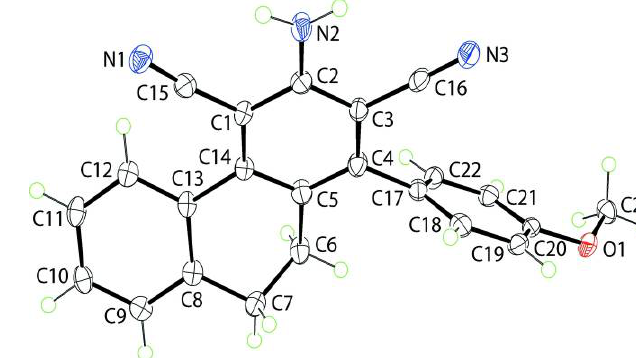
Figure 1. X-ray crystal structures of some dihydrophenanthrenes and